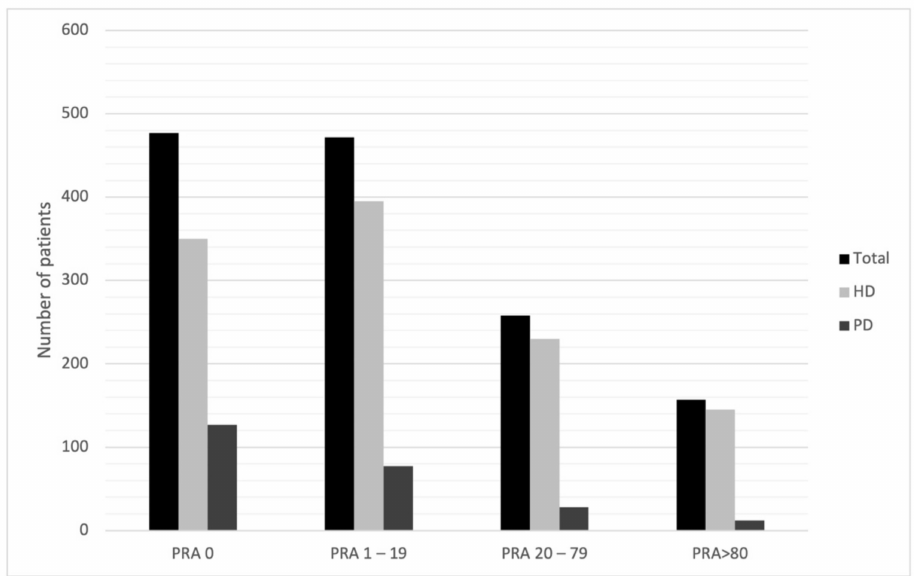
Figure 2. Patients divided according to PRA max. The classes were selected according to the study conducted by Bostock IC et al. [18]. HD: hemodialysis. PD: peritoneal dialysis.